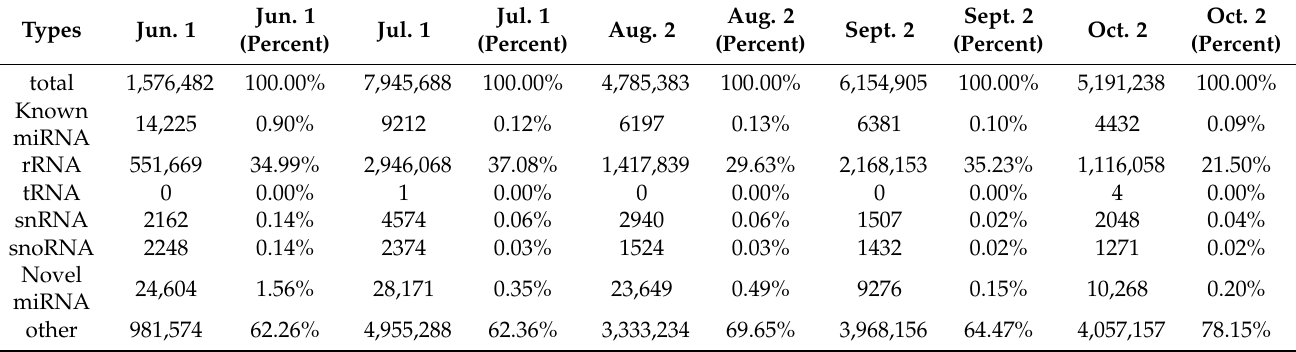
Table 2. Non-coding RNAs among the small